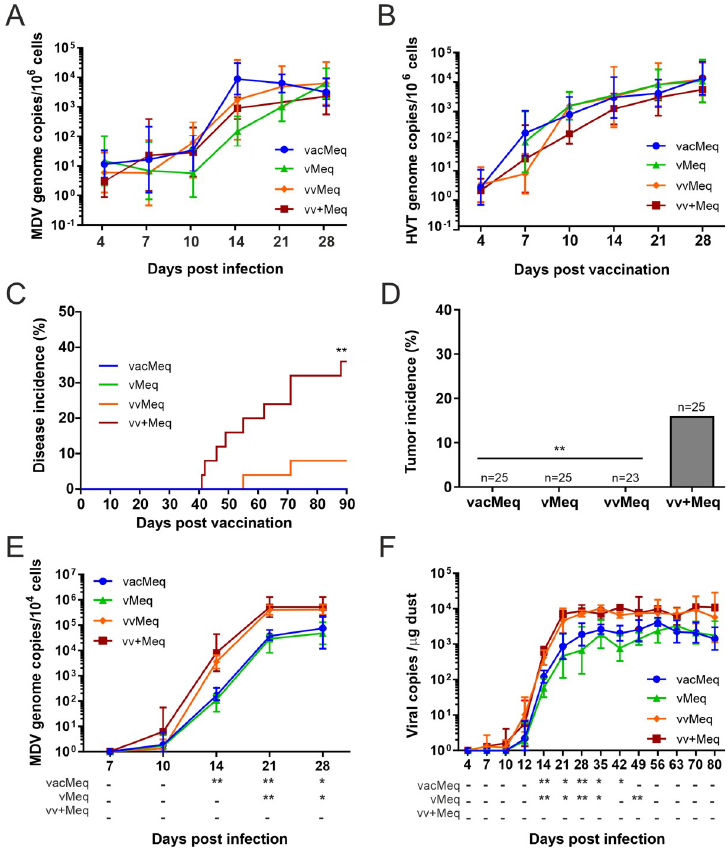
Fig 4. Pathogenesis and shedding of different meq isoform viruses in vaccinated chickens. Viral genome copy numbers of (A) the meq isoform viruses and (B) the HVT vaccine detected in blood of vaccinated chickens infected with the meq isoform viruses (p > 0.05, Kruskal-Wallis test). (C) Disease incidence and (D) tumor incidence in vaccinated chickens infected with indicated recombinant viruses. Asterisks ( �� p < 0.0125, Fisher’s exact test) indicate statistical differences to vv+Meq in (D). (E) Viral copies from feathers of the meq recombinant viruses. (A), (B) and (E): mean MDV genome copies per one million cells are shown for the indicated time points. (F) Viral copies per μ g of dust are shown for each group as validated previously [32]. Statistical differences in the feathers and dust samples are displayed as a comparison to vvMeq. Asterisks indicate significant differences ( � p < 0.05 and �� p < 0.0125; Tukey’s multiple comparisons